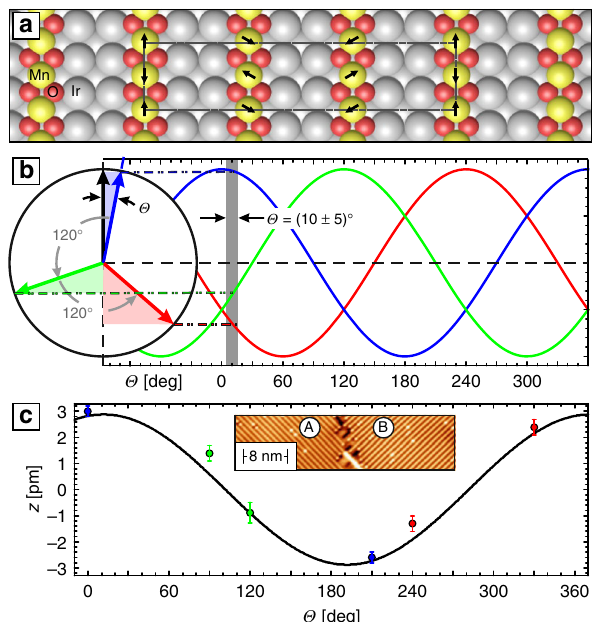
Fig. 3 Interpretation of SP-STM results by a chiral inter-chain exchange. a Schematic model of the chiral (9 × 2) spin structure of MnO 2 /Ir(001). b Sketch of the SP-STM signal expected on a sample with three domains rotated by 120° to another (see text and Eq. 1 for details). The corrugations data of Fig. 2b are best fi t with an angle θ = (10 ± 5)° between tip magnetization (black) and the nearest domain (blue). c Corrugation values determined by fi tting line pro fi les measured on two adjacent domains A and B (inset) as measured with an in-plane tip. The error bar represents the residual sum of squares. The black curve represents the cosine expected for an in-plane rotating spin Fig. 3b (offset by angle θ ). In this situation it is unavoidable that the projection of the other two arrows points into the direction opposite to the black arrow. This can also be veri fi ed by inspecting the right part of Fig. 3b, where we plot three cosine functions shifted by 120°.